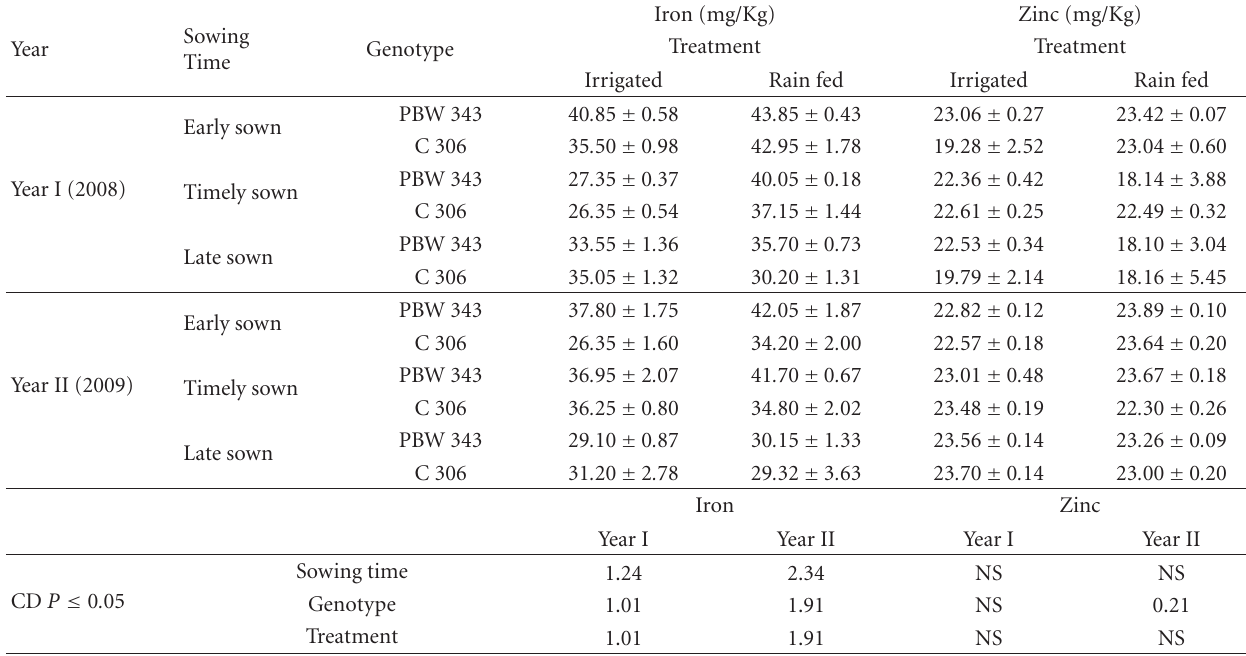
Table 3: E ff ect of sowing time on iron (mg/Kg) and zinc (mg/Kg) contents in mature grains of drought-susceptible (PBW 343) and drought- tolerant (C 306) wheat genotypes grown under irrigated and rain-fed conditions. Values are mean ± standard deviation of three replicates; CD, critical di ff erence; NS, not